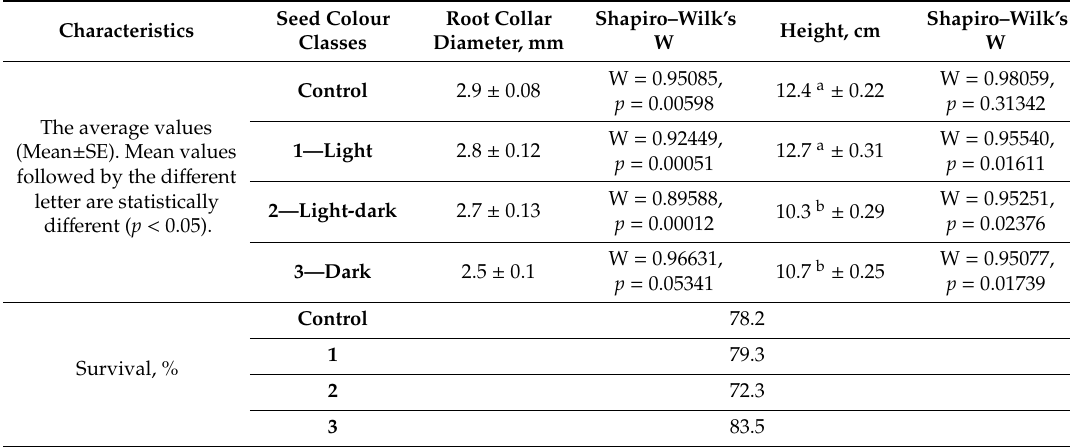
Table 3. The growth of Pinus sylvestris L. seedlings produced from di ff erent seed colour classes in the first growing season after the outplanting at experimental site. Seedlings were measured at the end of the growing season (28 March 2019). Mean values followed by the di ff erent letter are statistically di ff erent used Tukey’s HSD test ( α =